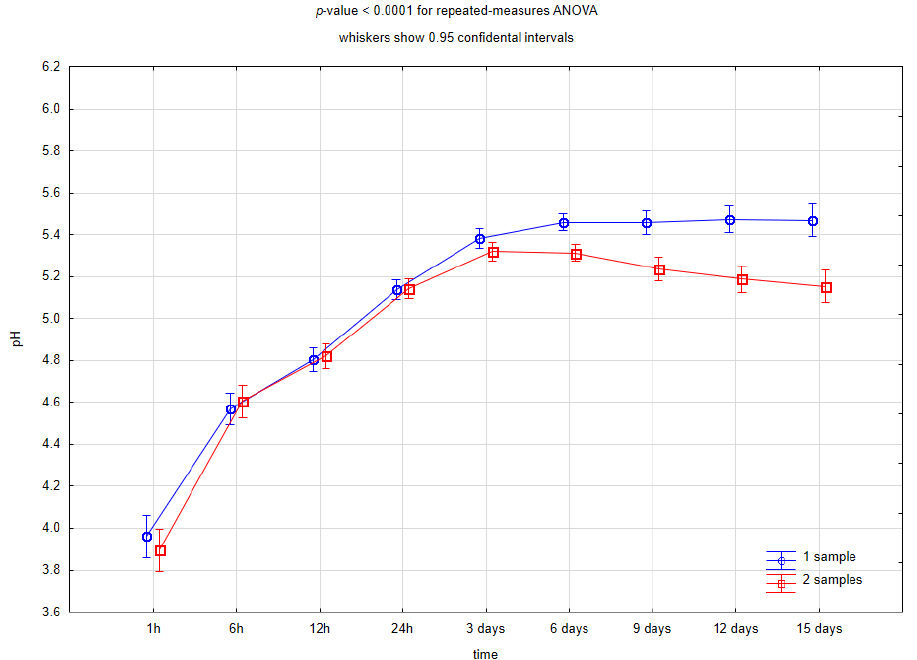
Figure 6. Repeated-measures analysis of variance for pH values in the individual time points depending on the number of the samples for RIVA LC.